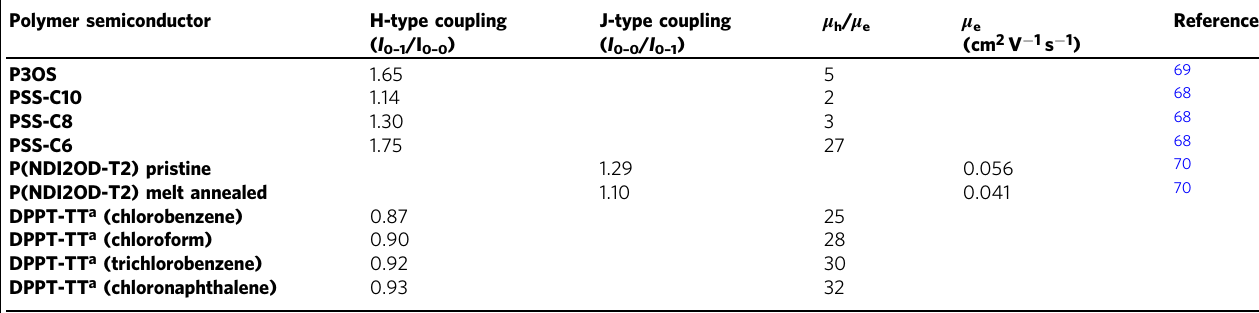
Table 1 Relating relative mobilities with the relative content of H-type and J-type coupling in ambipolar polymer (P3OS 69 , PSS- C10, PSS-C8, and PSS-C6 68 ) and electron transport to J-type coupling content in unipolar polymer (P(NDI2OD-T2))